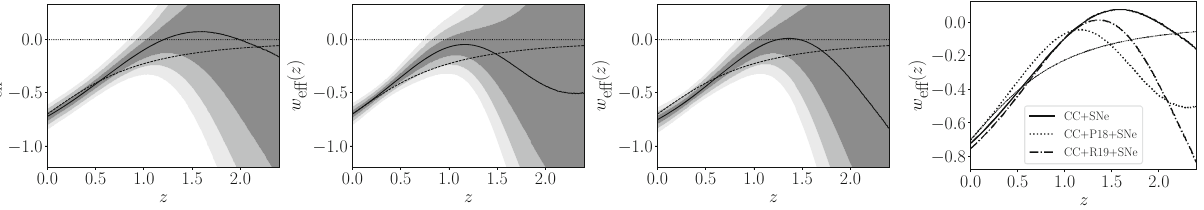
Fig. 11 Plots for the reconstructed jerk j , using the P18 + CC + Pantheon data (left) and from R19 + CC + Pantheon data (middle). The black dashed line corresponds to the (cid:2) CDM model, with (cid:12) m 0 = 0 . 3 where j = 1. A comparison among the three cases is shown in the right column